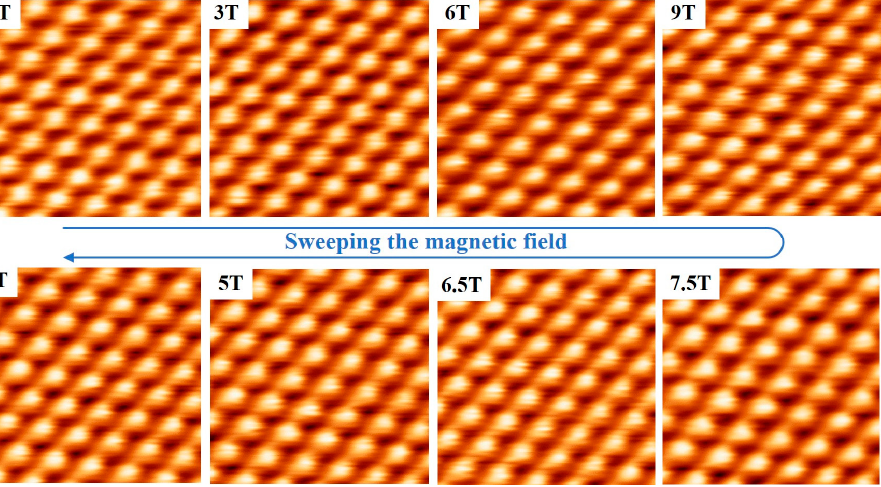
Figure 7. Continuous STM images of HOPG obtained in sweeping magnetic fields from 0 T to 9 T at 70 K with bias voltage +200 mV and average tunneling current 5 nA. The scan area is 1.5 nm × 1.5 nm.